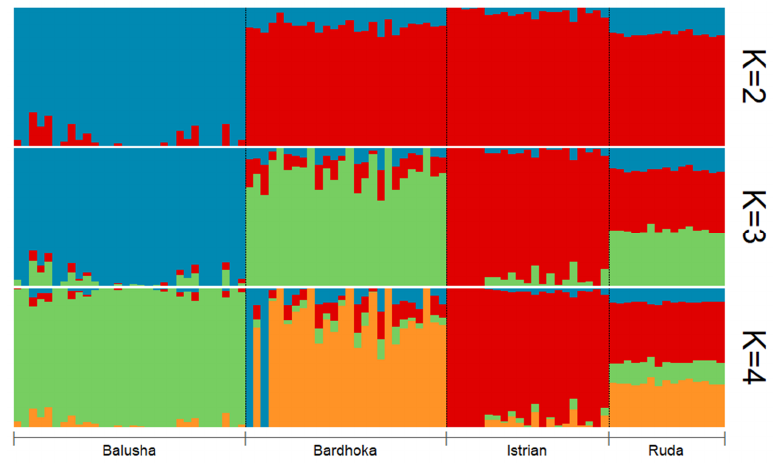
Figure 3. Admixture plot for all sheep breeds (Balusha, Bardhoka, Istrian and Ruda) analyzed in the study. A clear pattern of ancestry is visible for the breeds. Please note that K = 3 was identified as the optimal number of clusters.